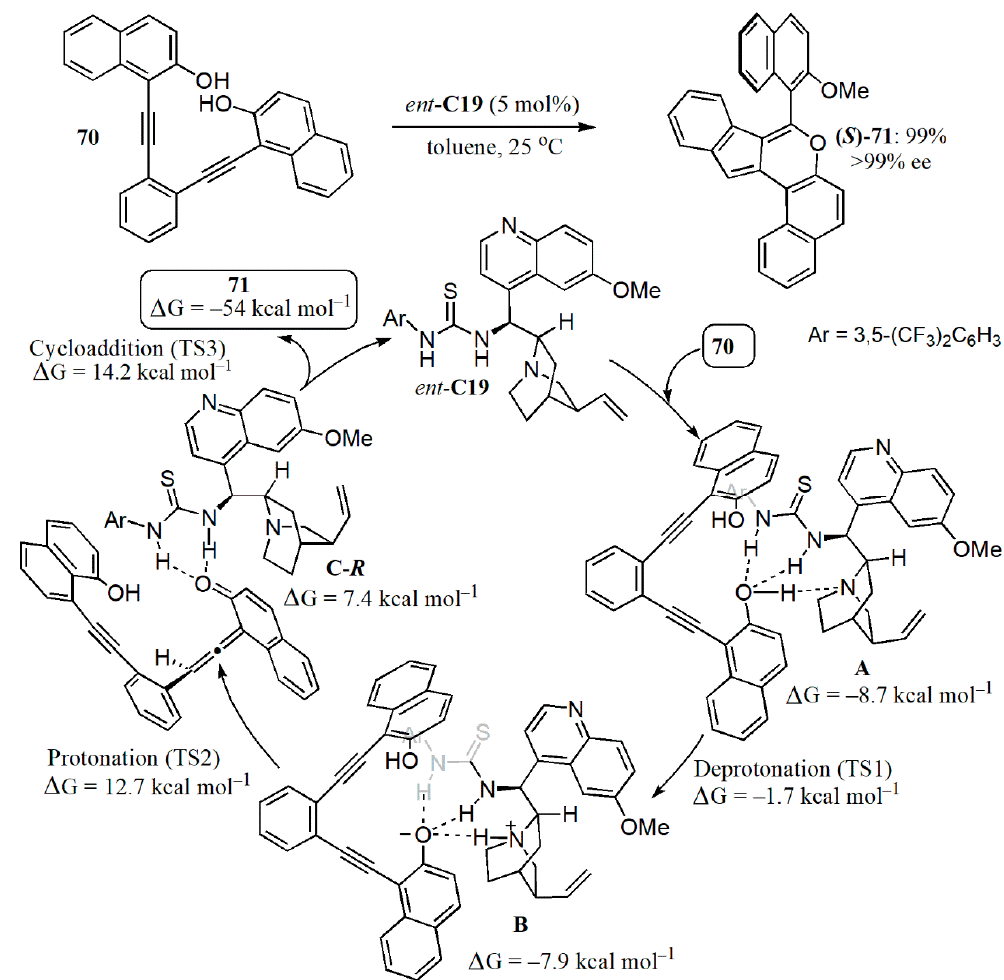
Figure 39. Intramolecular [4+2] cycloaddition of 2-ethynylphenol and the proposed catalytic cycle; the relative energies are given concerning catalyst ent - C19 with substrate 70 [79]. The free energies were obtained by adding DGcorr (the thermochemical correction for the Gibbs free energy calculated at the B3-LYP/6-31G(d) level in the gas phase) to DEM11/solvent (the single-point energy calculated at the M11/6-311+G(d,p) level in toluene-based on the gas-phase stationary point).